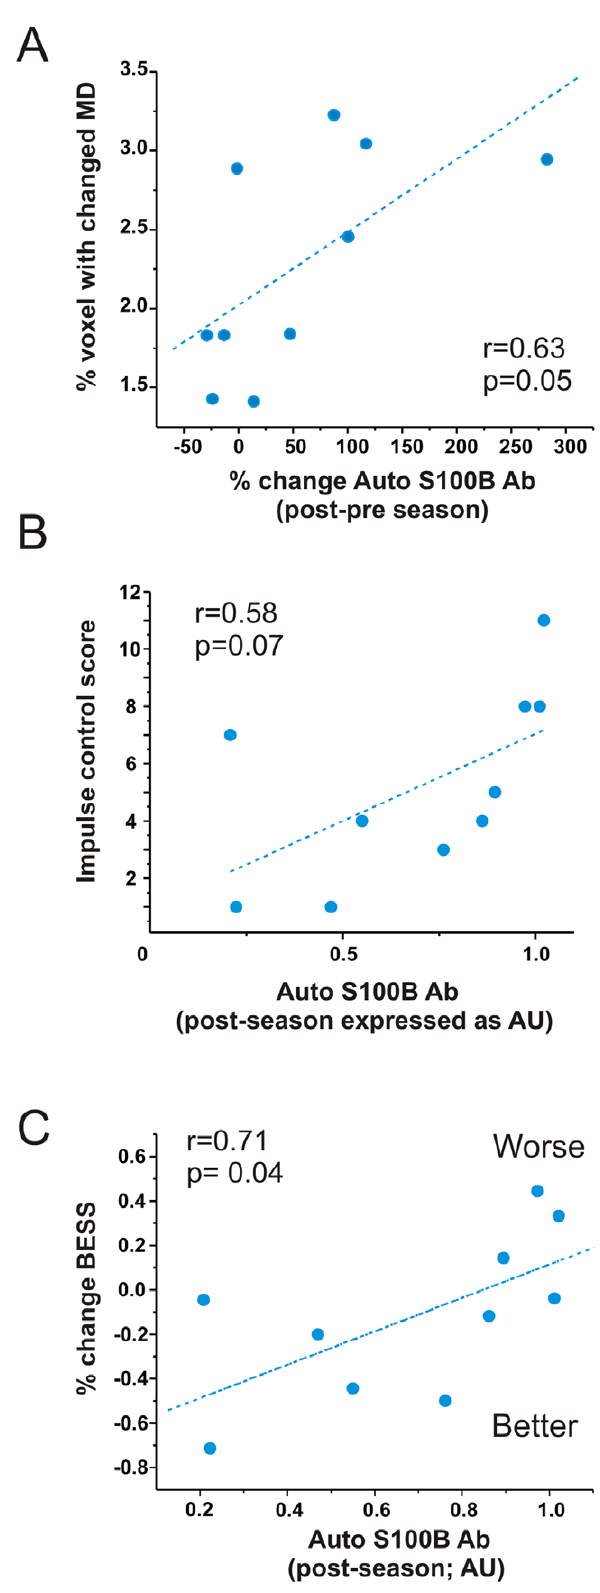
Figure 5. Auto-antibodies in serum correlate with DTI and cognitive changes. A ) Mean diffusivity index expressed as percent